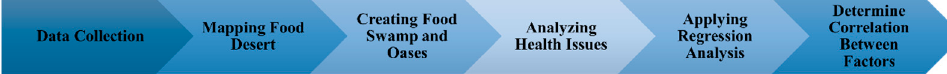
Figure 2. Methods. Figure 2.